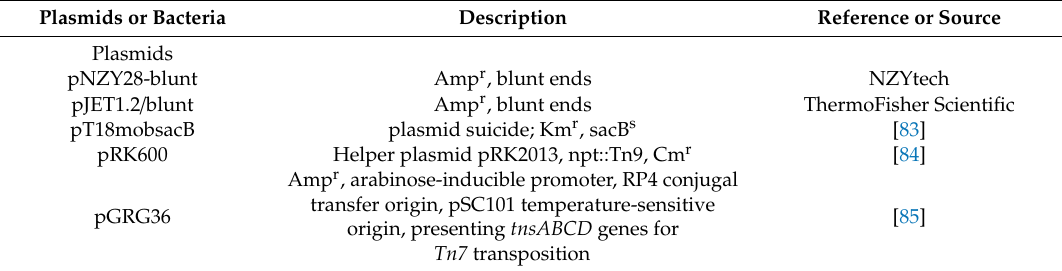
Table 1. Bacterial strains and plasmids used in this